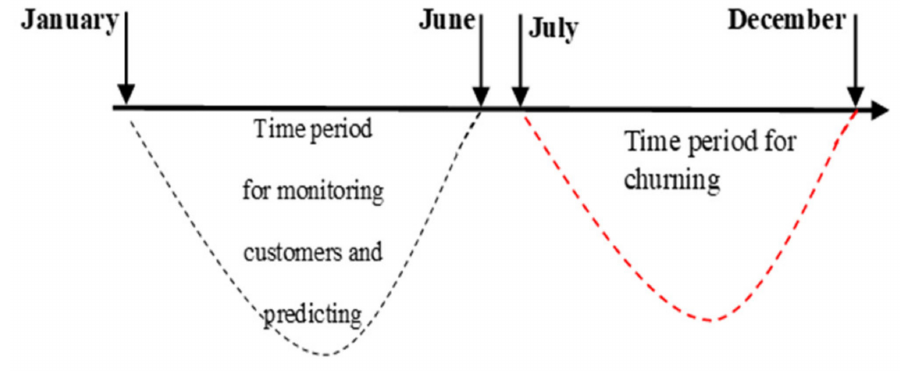
Figure 4. Time window of the prediction